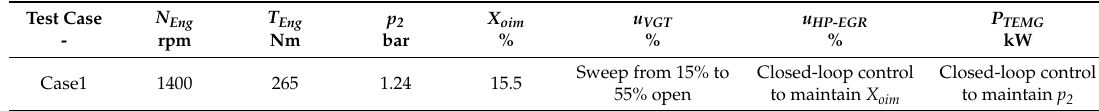
Table 5. Test case set-up for steady-state investigation of assist